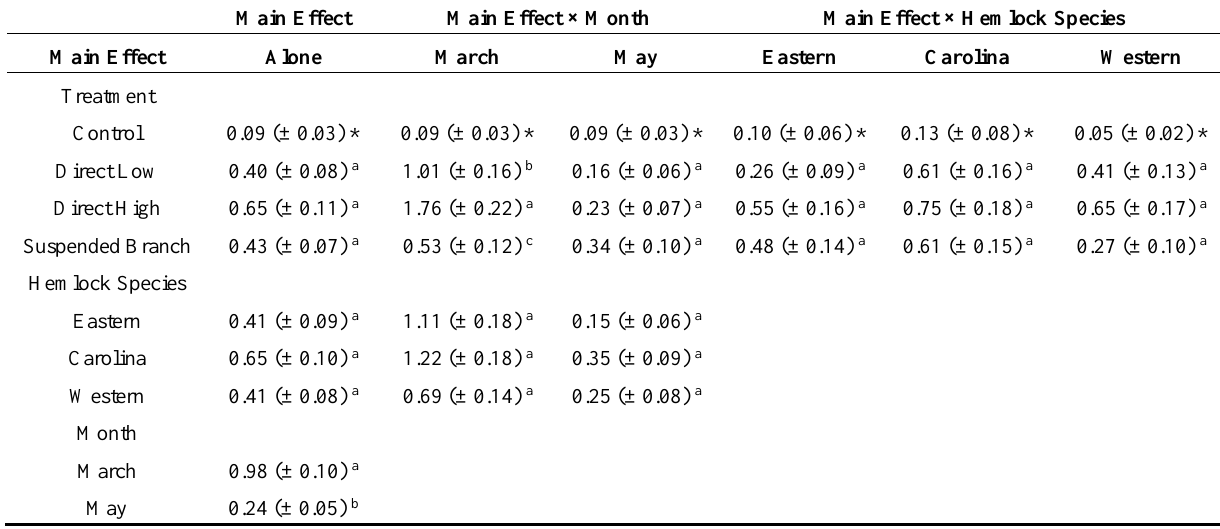
Table 1. Mean (± SE) hemlock woolly adelgid densities (sistens nymphs per 10 cm twig sample) on hemlock seedlings in November 2012, by main effect (infestation treatment, hemlock species, and treatment month) and interactions of main effects by month and hemlock